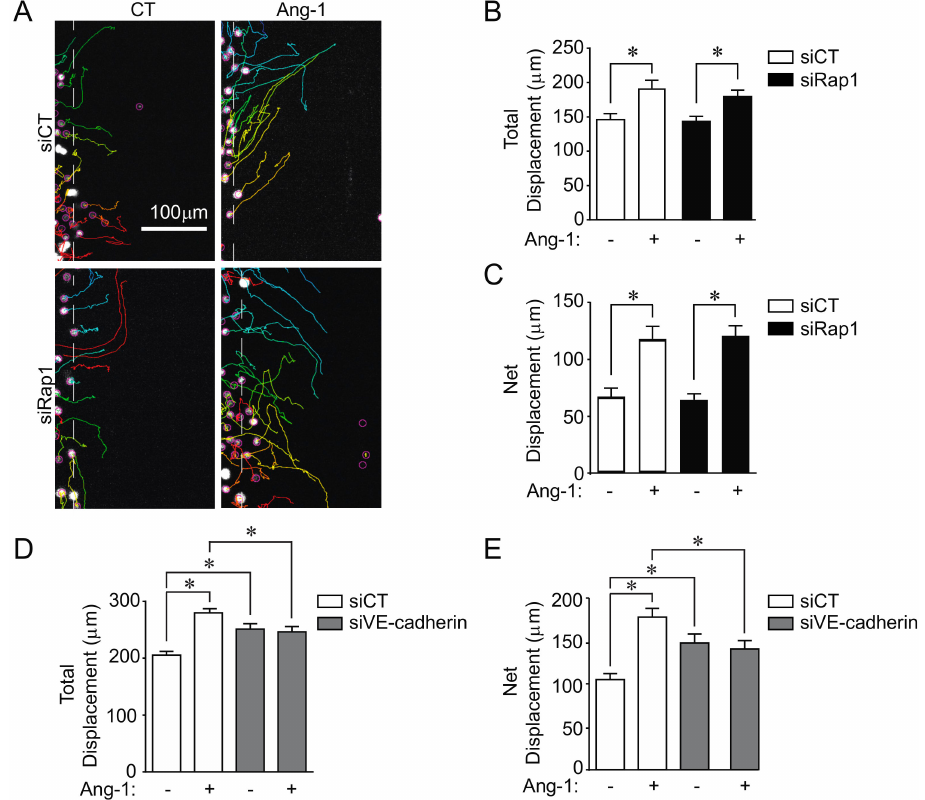
Figure 4. VE-cadherin, but not Rap1, is essential for Ang-1-induced BAEC migration. ( A ) Representative images of trajectories of migrating BAECs captured by live-cell imaging during 6 h of migration. BAECs were transfected with control siRNA (siCT) or targeting Rap1 (siRap1) and treated with Ang-1 (100 ng / mL), where indicated. ( B , C ) Quantifications of total and net cell migration. Graphs are representative of three independent experiments, each yielding similar results. At least 60 cells per experiment were quantified (* p < 0.05). ( D – E ) BAECs were transfected with control siCT or targeting VE-cadherin (siVE-cadherin), and treated with Ang-1 (100 ng / mL) where indicated, showing quantifications of total and net cell migration. Graphs representative of three independent experiments, each yielding similar results. At least 60 cells per experiment were quantified; * p <